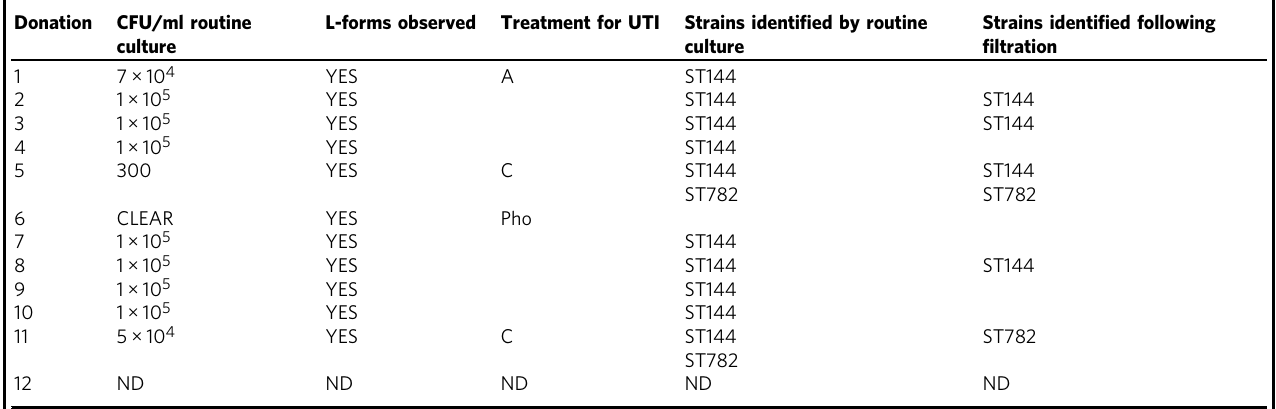
Table 1 Recurrence of E. coli strains in patient UTI343 treated with phosphomycin (summary of results) Donation CFU/ml routine culture